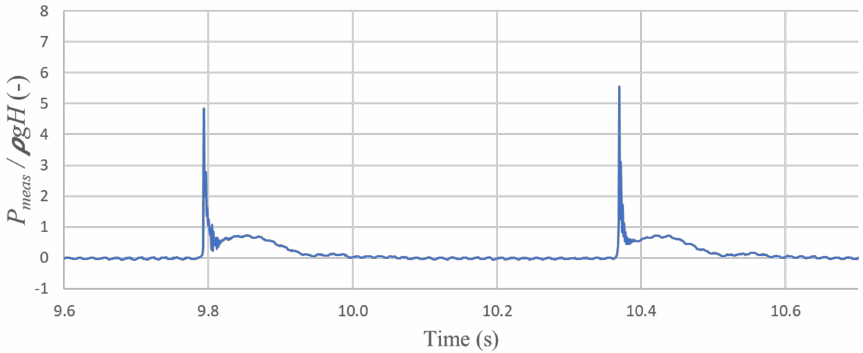
Figure 9. Impact pressure measured during the no duct case at the breaking wave position with H = 0.07 m and T = 0.57 s. A maximum pressure of up to 6.5 times the hydrodynamics pressure was recorded, with rise time ( t r ) of 0.003 s recorded.